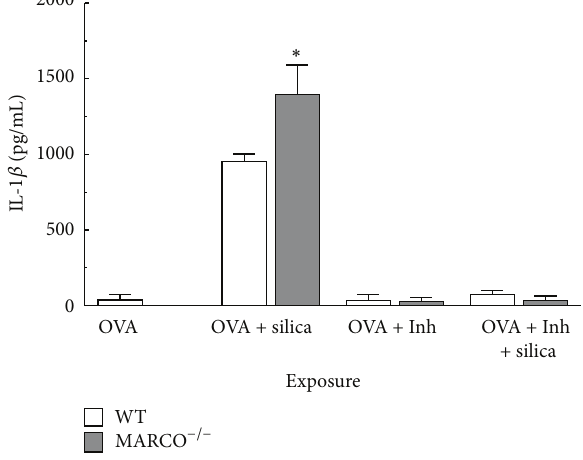
Figure2: CathepsinBactivationinMARCO −/− andWTAMexposed to silica. MARCO −/− AM and WT AM were stimulated with or without LPS (20ng/mL) and then exposed to silica (100 𝜇 g/mL) for 2 hrs prior to cathepsin B activity assay. Mean ± SEM cathepsin B activity where white bar indicates WT AM and grey bar indicates MARCO −/− AM. Hashtag # indicates 𝑃 < 0.05 compared to MARCO −/− unstimulated (cells only) group.